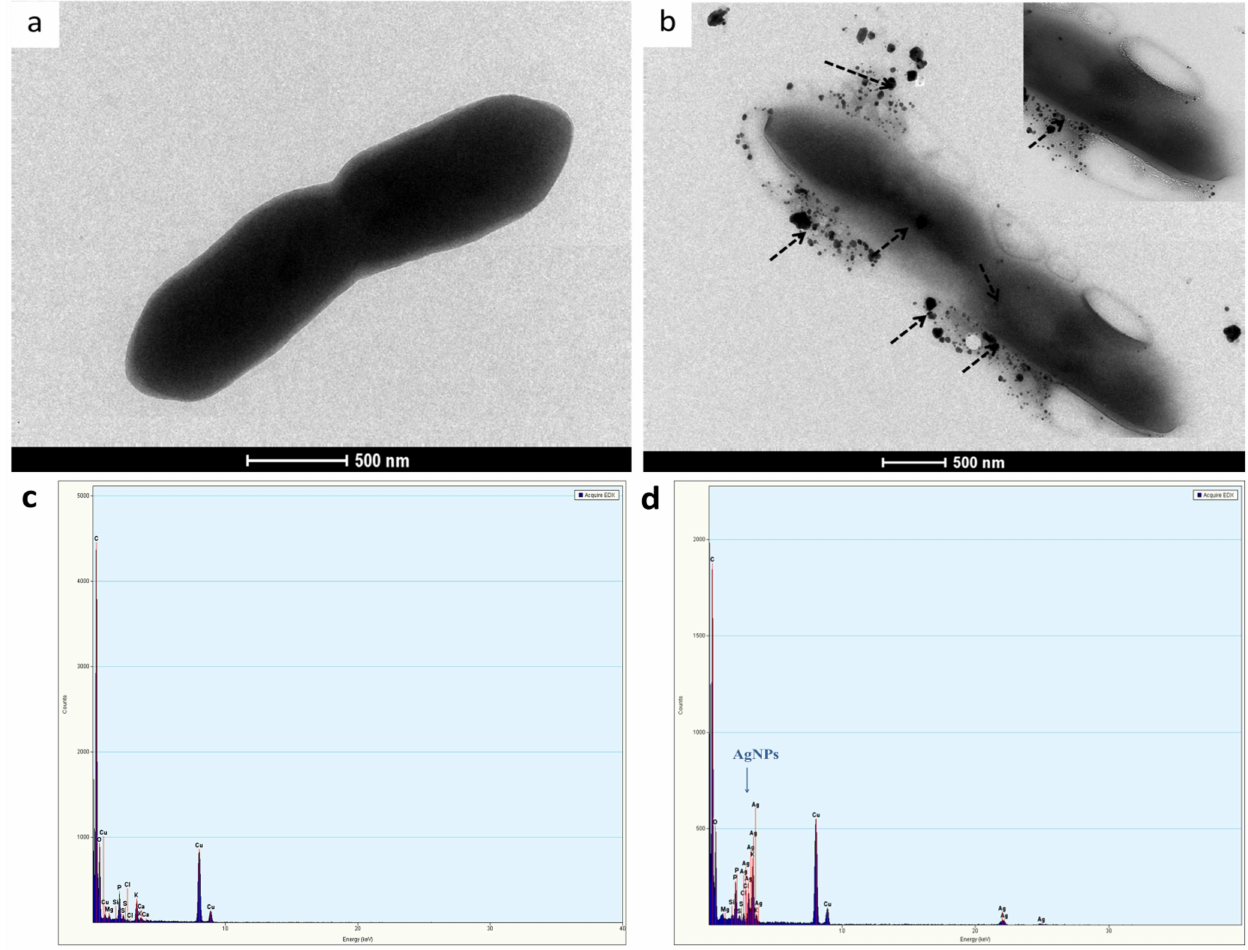
Fig 7. TEM micrographs and EDX spectraof B . pseudomallei 316c. (a) normalcell in 10 mM PPB; (b) bacterial cell treated with 1/5 MIC of AgNPs for 1 h at 37˚C (dashedarrows point to the AgNPs on the outer membrane and inside the cell); (c) EDX spectra of the untreatedcells and (d) EDX spectra of the cells treated with 1/5 MIC of